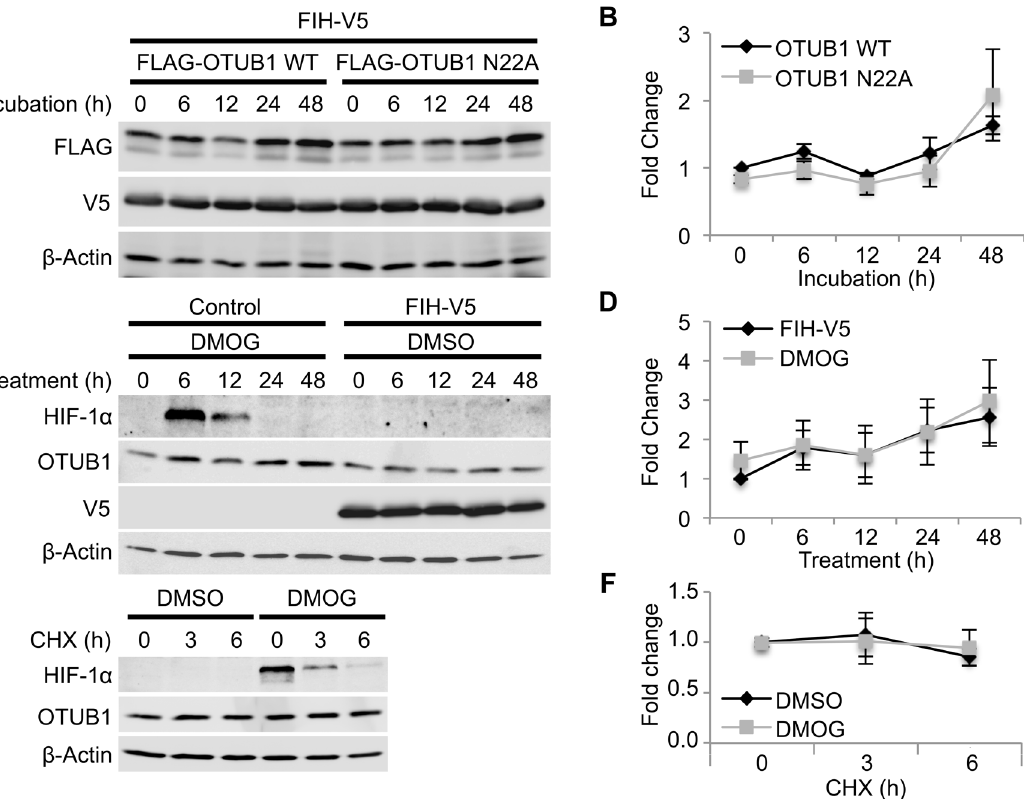
Fig 6. OTUB1 N22 hydroxylation does not impact on OTUB1 protein level and half-life. (A) HEK293 cells stably expressing shOTUB1 (targeting the 3 0 UTR to diminish endogenous OTUB1 protein) and FLAG-OTUB1 WT or N22A were transiently transfected with FIH-V5 for 24 h followed by western blot analysis of OTUB1 WT and N22A protein levels at the indicated time points. (B) Densitometric analysis of OTUB1 WT and N22A protein levels. OTUB1 protein levels were normalized to β -actin loading control. (C) HEK293 wild-type cells were transiently transfect with either control plasmid or pFIH-V5 (to maximize OTUB1 hydroxylation) for 24 h and subsequently treated with either 1 mM DMOG (to prevent OTUB1 hydroxylation) or DMSO for the indicated time points. Endogenous OTUB1 protein levels were analyzed by western blot. (D) Densitometric analysis of endogenous OTUB1 protein levels. OTUB1 protein levels were normalized to β -actin loading control. (E) HEK293 wild-type cells were pre-treated with DMSO or 1 mM DMOG (to inhibit OTUB1 hydroxylation) for 16 h prior to the treatment with 50 – 100 μ g/ml cycloheximide (CHX) for the indicated time points. Endogenous OTUB1 protein levels were analyzed by western blot. (F) Densitometric analysis of endogenous OTUB1 protein levels. OTUB1 protein levels were normalized to β -actin loading control. Data are presented as representative blot or as mean ± SEM of n = 3 independent experiments. The underlying data of panels B, D, and F can be found in S1